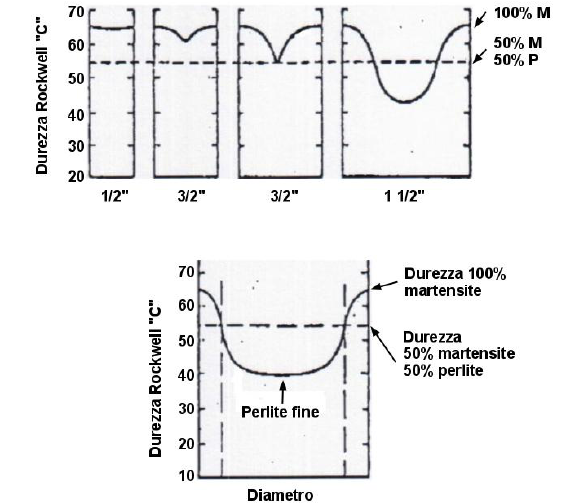
Figura 1: Curve ad U schematiche per un acciaio di composizione eutettoidica. Figure 1: Schematic hardness test traverses (U curves) for an eutectoidic